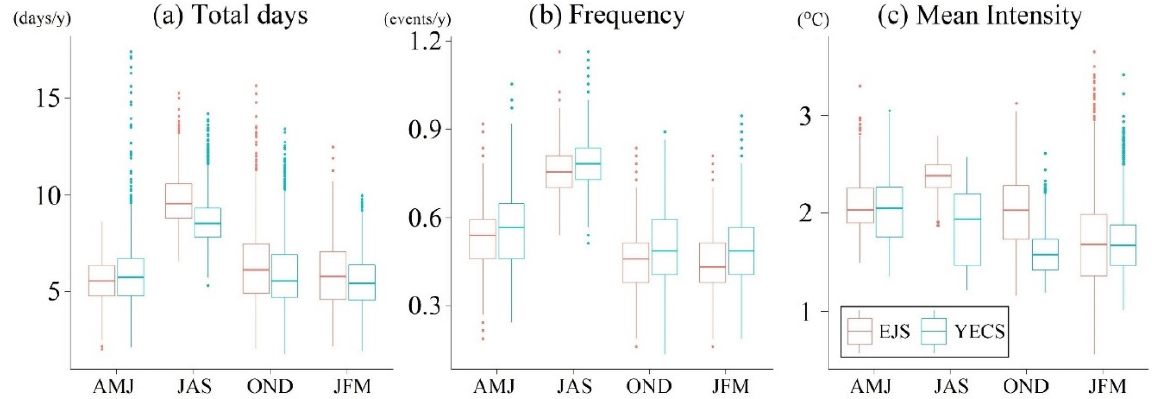
Figure 4. Boxplot of seasonal MHW characteristics in the EJS and YECS from 1982 to 2018: ( a ) Total days, ( b ) frequency, and ( c ) mean intensity. Horizontal lines inside the boxes indicate the median. The bottom and top of the box boundaries indicate the first and third quartiles, respectively.